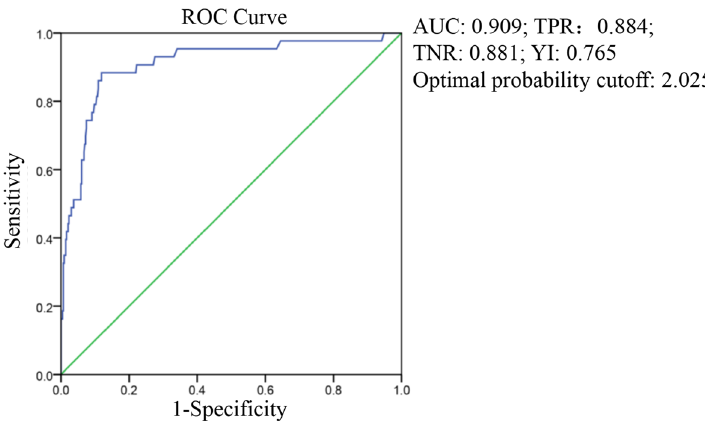
Figure 2. ROC curve of D-dimer from the last test, in predicting hospital discharge and